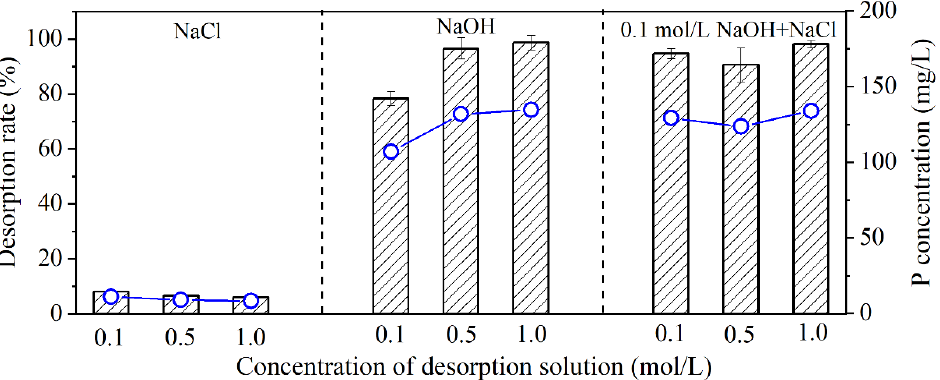
Figure 5. Desorption performance of different desorption agents. The bars indicated the desorption efficiency and the lines indicated the phosphate concentration.